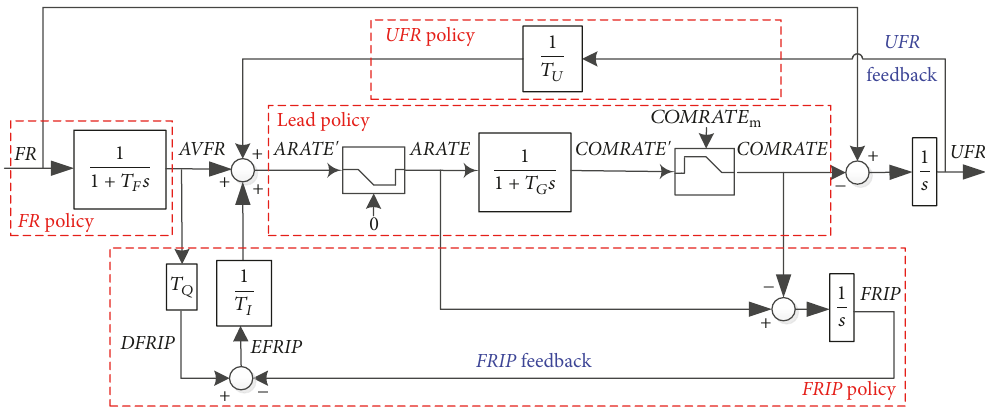
Figure 3: Nonlinear model of handling chain system in container